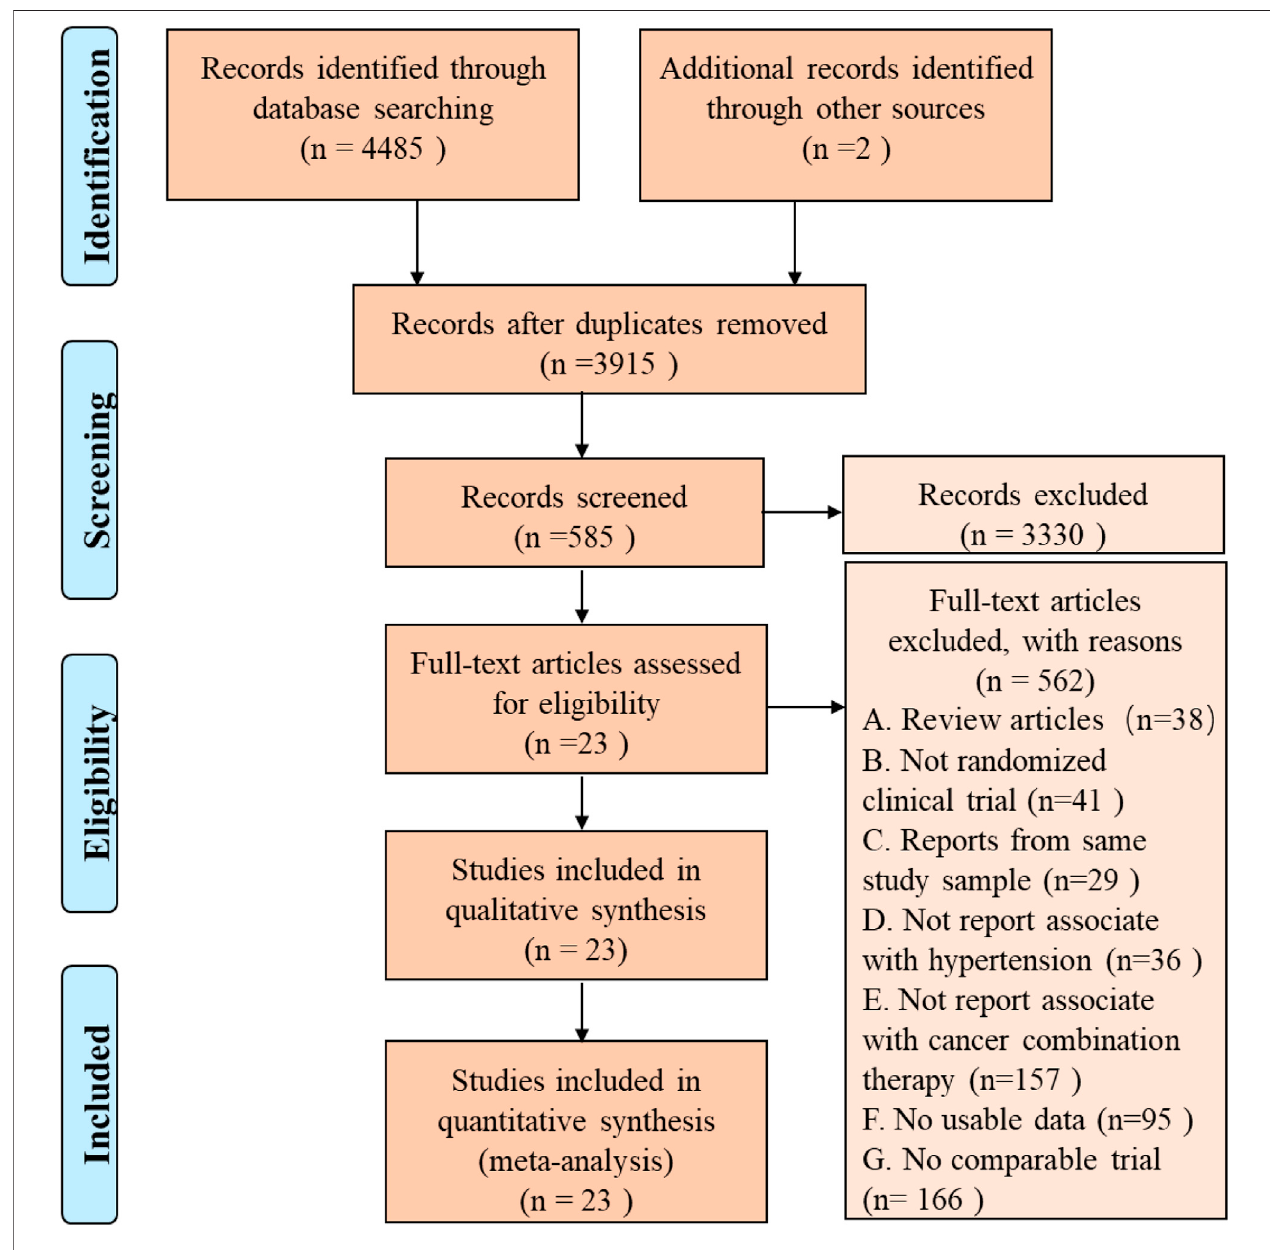
FIGURE 1 | PRISMA Flow Diagram of Study Selection for this